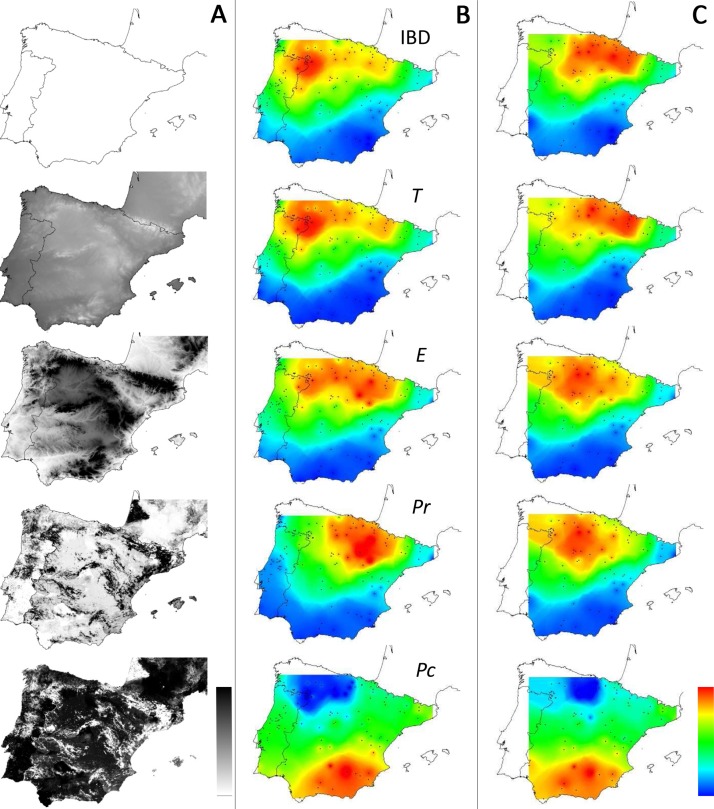
Distribution of supported IBR hypotheses through Mantel tests for the environmental features tested.(IBD: Euclidian distances; T, mean minimum temperatures; E, elevation; Pr, high pine densities as barriers; Pc, high pine densities as corridors). Gray maps (A) refer to the distribution of environmental features associated with resistance models (from white to black: low to high resistance values). Colored maps refer to interpolations of supported IBR hypotheses on the whole dataset (B) and within the Eastern Iberian cluster only (C). From blue to red: low to high frequency of study areas with supported resistance models.